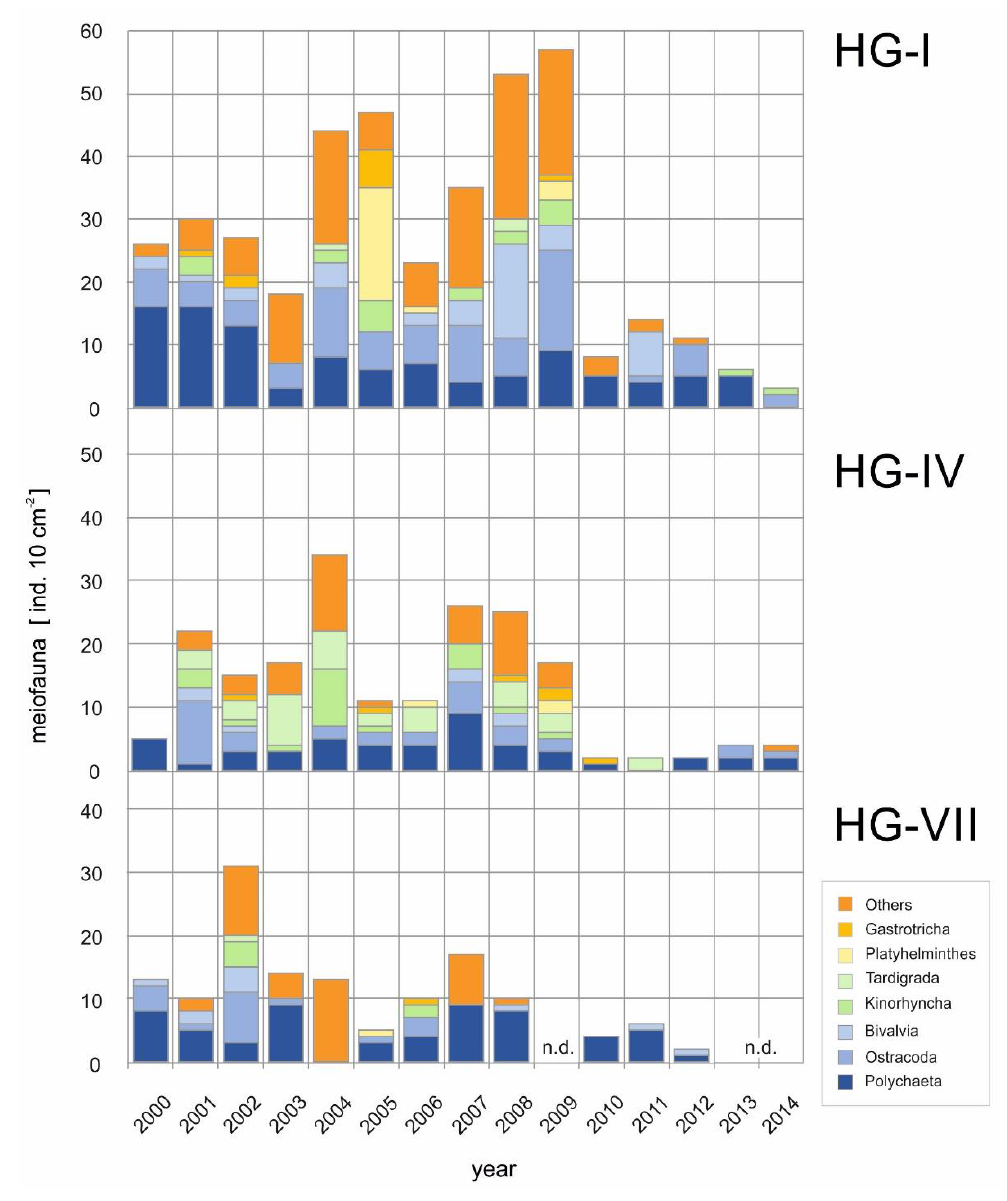
Figure 3. Meiofauna taxa occurring in minor quantities ( < 2% of the total metazoan meiofauna) at HAUSGARTEN sites HG-I (1280 m), HG-IV (2500 m), and HG-VII (4000 m) between 2000 and 2014 (n.d. = no data).